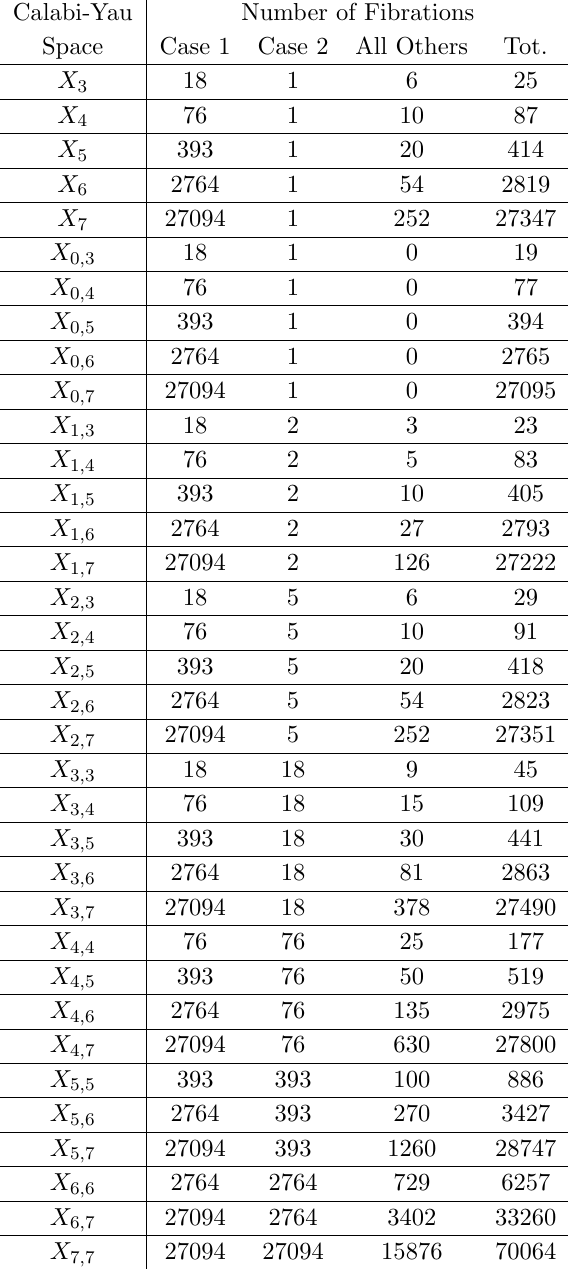
Table 3 . The statistics of distinct genus-one (cid:12)brations for all the Calabi-Yau threefolds in table 1, where the Calabi-Yau hypersurfaces are embedded in the Fano fourfolds as X r;s (cid:26) dP r (cid:2) dP s and with the base surface being the second and the (cid:12)rst ambient factor, respectively (incl. all their blow downs); this is consistent with the case distinctions in section 5.1.2.